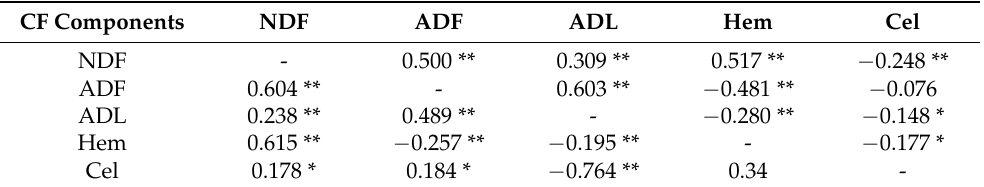
Figure 1. Phenotypic frequency distributions in crude fiber components of the B. napus shoots. The x-axis represents the content (%), and the y-axis represents the frequency. “A” and “H” indicate the average of the female parent ‘APL01 (cid:48) and the male parent ‘Holly’, respectively. The codes 22GY, 22NJ, 21GY, and 21NJ are for the following different years and environments: 2022 Guiyang, 2022 Nanjing, 2021 Guiyang, and 2021 Nanjing, respectively. The frequency distribution of ( a ) hemicellulose content, ( b ) cellulose content, ( c ) acid detergent lignin content, ( d ) neutral detergent fiber content, and ( e ) acid detergent fiber content. Table 2. Correlation coefficient of crude fiber component in Guiyang (above diagonal) and Nanjing (below diagonal). CF Components